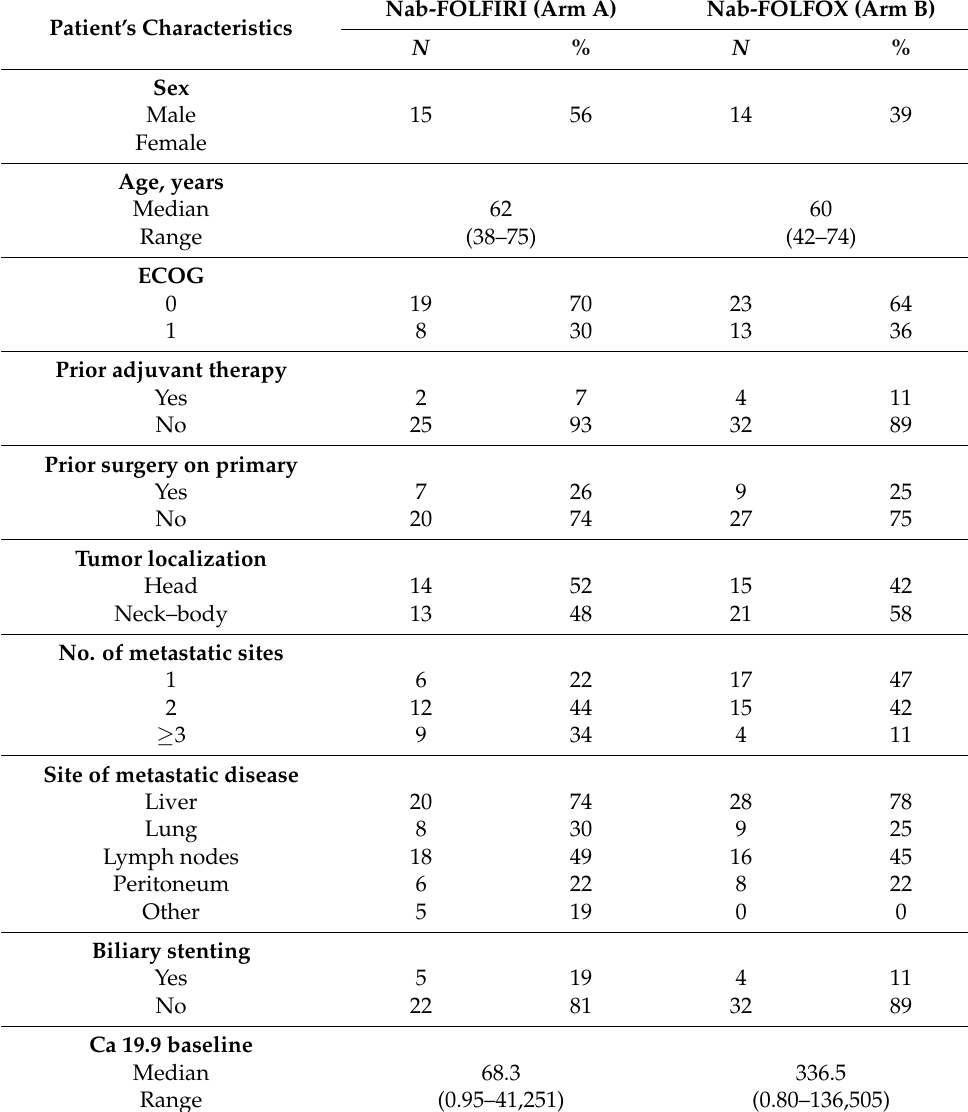
Table 1. Phase I: patient’s